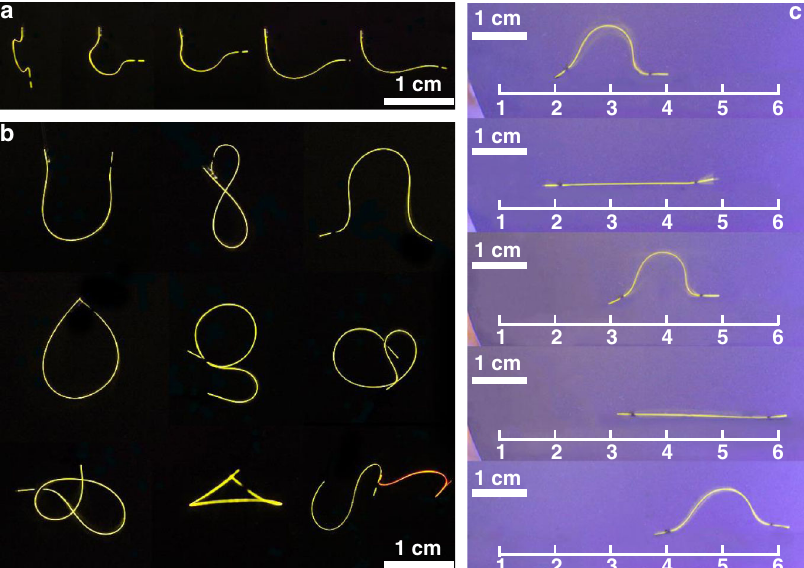
Fig. 2 Shape-shifting and motility of hybrid magnetic organic crystals. a , b Photographs of MNP// 4 and MNP// 5 that were reshaped by using magnetic fi eld observed under UV light. Note that the contrast of the color in these images was enhanced for clarity. c Example of an inchworm-like motility of MNP// 4 induced by a temporally evolving spatial gradient in the magnetic fi eld. The white scale bar corresponds to a length of 1 cm. Note that the contrast of the color in these images was enhanced for